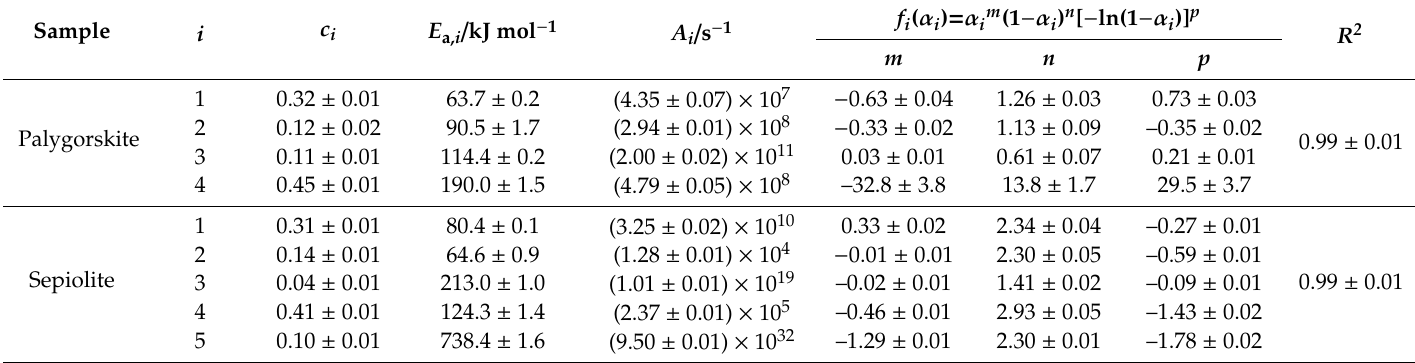
Table 1. The average kinetic parameters optimized by KDA for each reaction step of the thermal decomposition of the purified clay